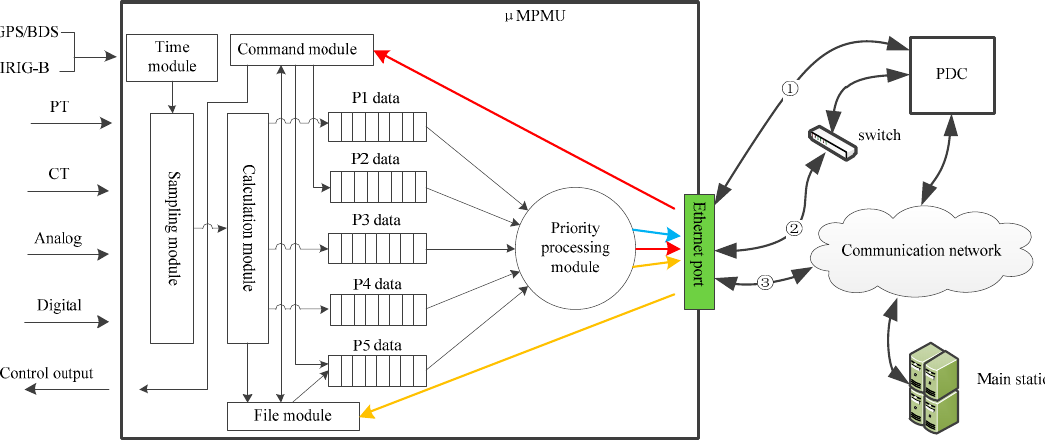
Figure 7. The micro multifunction phasor measurement unit ( μ MPMU) multi-priority data processing model.